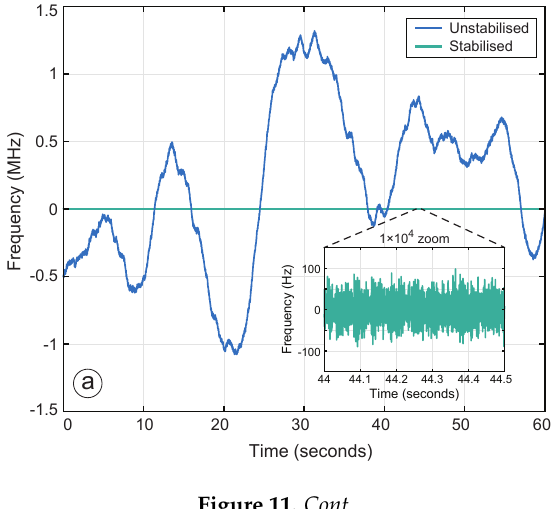
Unstabilised Stabilised